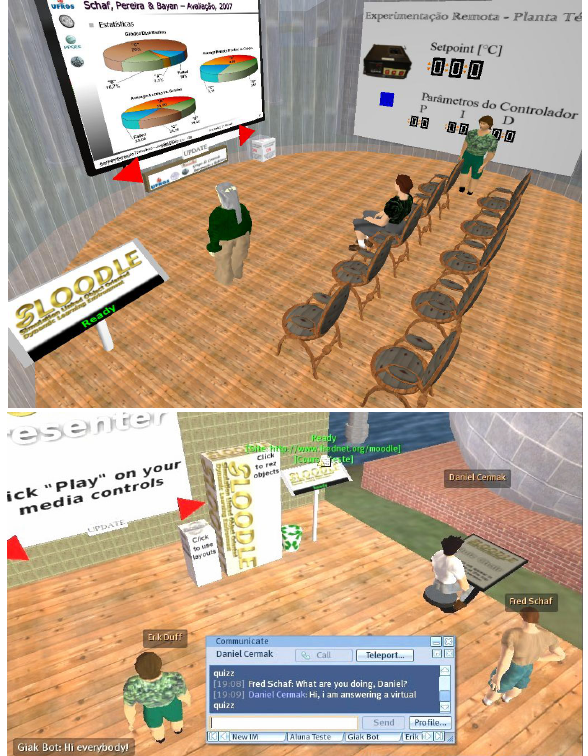
Figure 8. Collaboration in 3D AutoSysLab